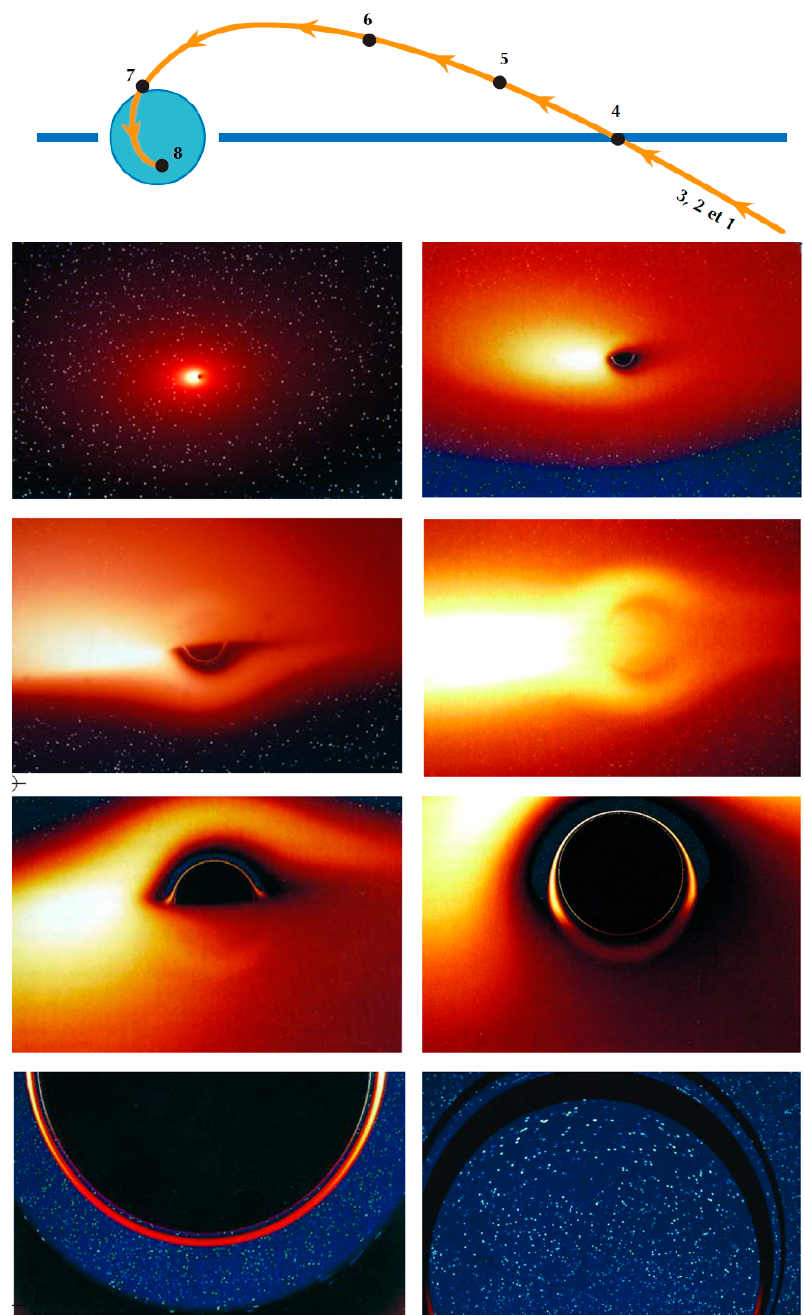
Figure 2. Colour simulations of a black hole accretion disk taking account of the Doppler and gravitational shifts. The images are calculated at positions 1 to 8 of the plunging trajectory schematized above. The last picture is taken from inside the black hole, the observer having rotated by 180° to watch the outside. © J.A Marck and J.-P. Luminet, from [12].